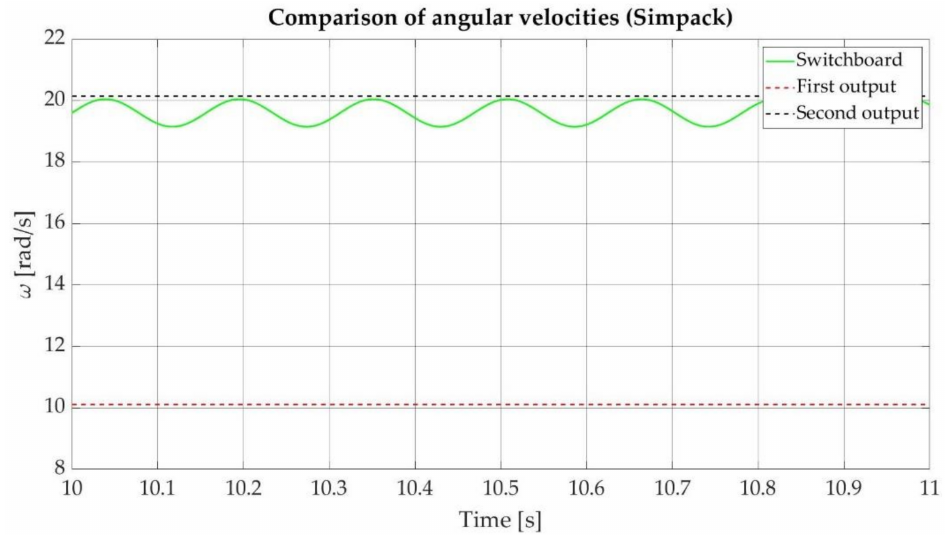
Figure 12. Comparison of the angular velocities of the first output, second output, and switchboard— results from